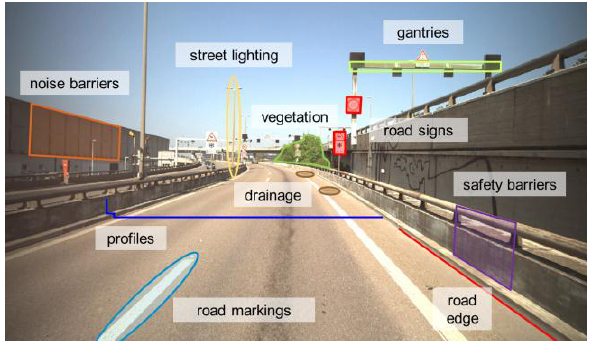
Figure 1. Vision-based road infrastructure management – typical focal points and objects of